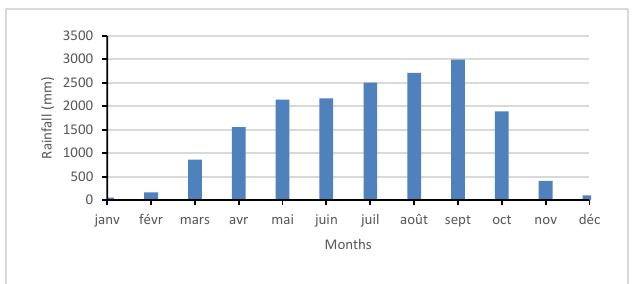
Figure 3: Rainfall average over the region from 2000 to 2017